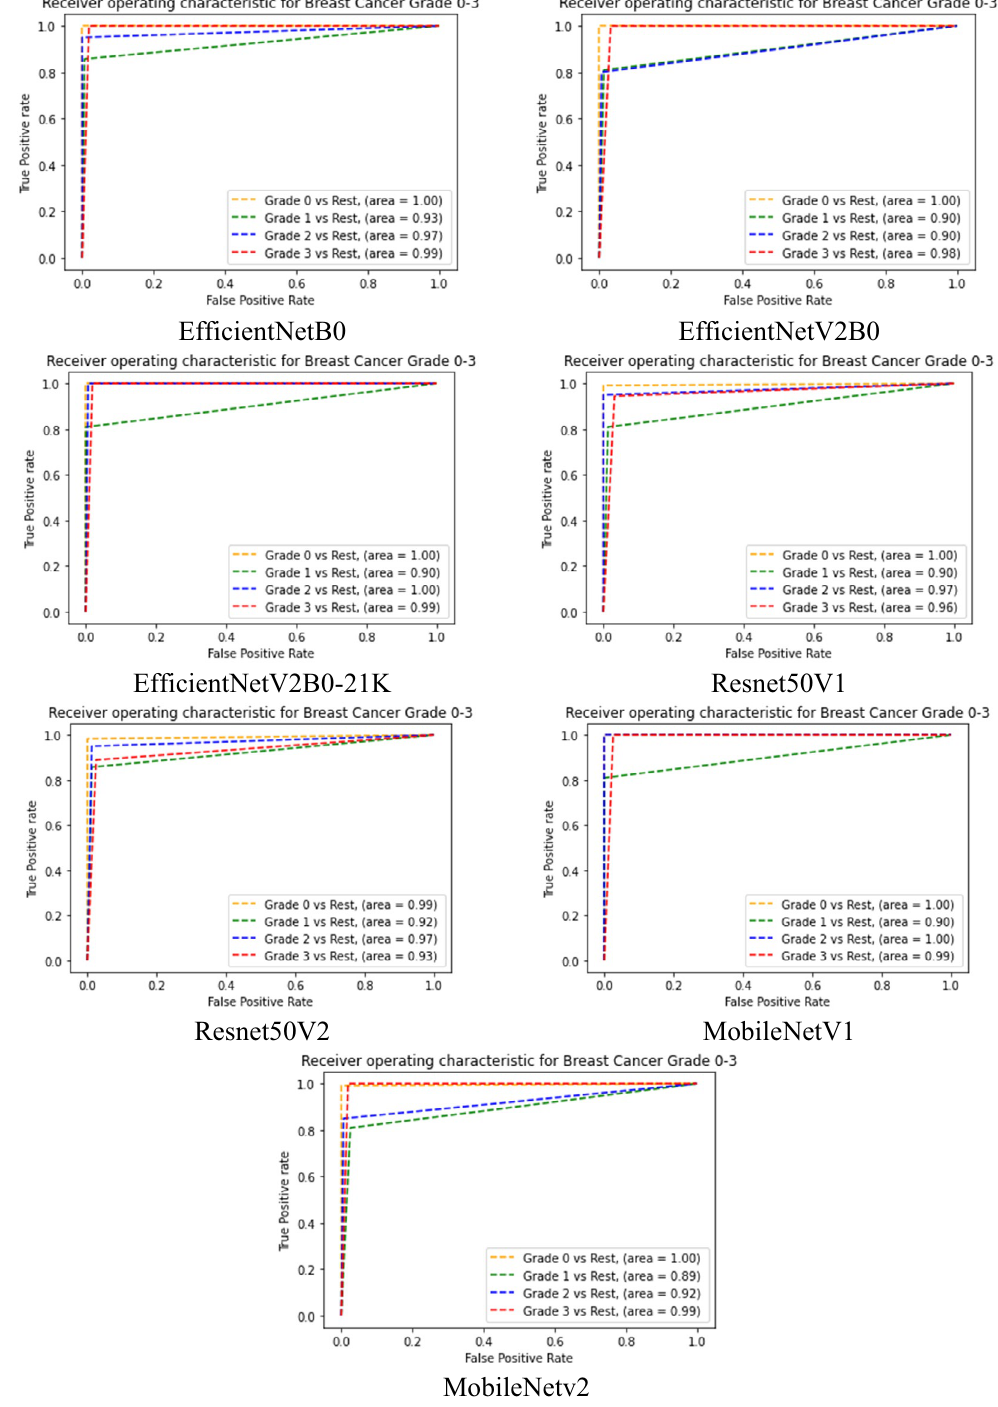
Figure 8. ROC curves for each of the seven chosen comparative CNN models (training set from 80% of FBCG dataset used previously for the fivefold stratified CV) on test set (20% of FBCG dataset). It shows that, on average, all the chosen models exhibited highest performance in identifying Grade 0 and lowest performance in identifying Grade 1 (except